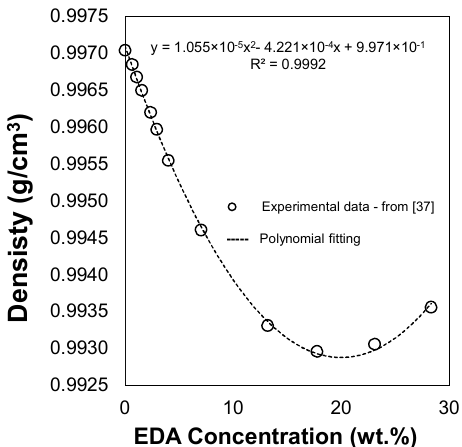
Figure A1. Density vs. EDA solution concentrations.